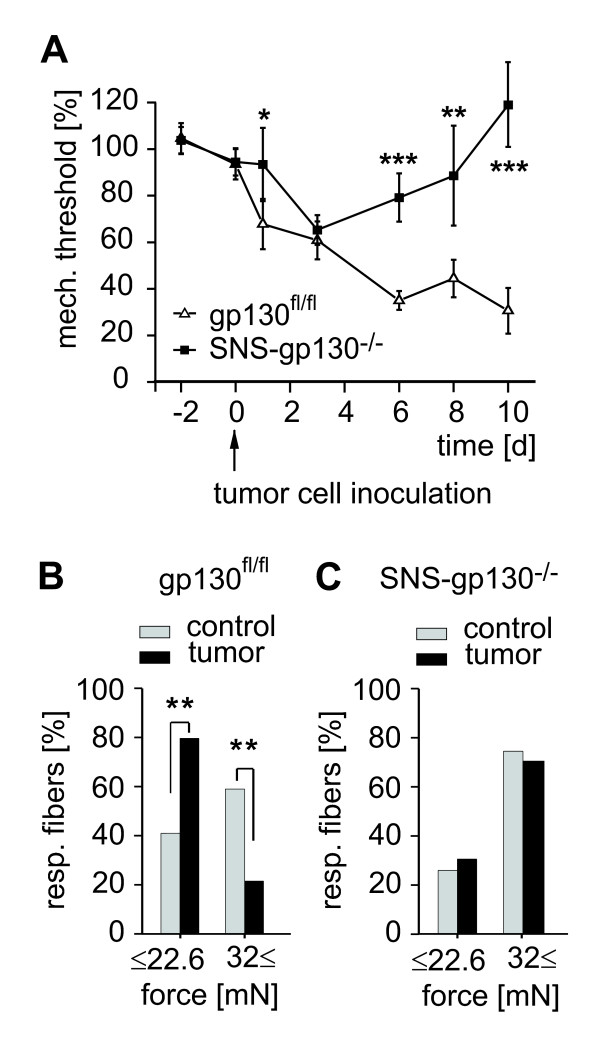
Neuronal signal transducer gp130 plays a role in tumor-induced mechanical hyperalgesia. (A) Mechanical threshold after tumor induction in the hind-paw of gp130fl/fl (open triangle n = 17) and SNS-gp130-/- (black square, n = 11) mice. After inoculation with tumor cells mechanical thresholds dropped by 30% in both mouse strains, but in SNS-gp130-/- mice the degree of hypersensitivity was significantly reduced in comparison to gp130fl/fl mice at day 1, 6, 8, and 10 (* p < 0.05, ** p < 0.01, *** p < 0.001; ANOVA). (B, C) Mechanical von Frey thresholds of fibers recorded in in vitro skin-nerve preparation from gp130fl/fl and SNS-gp130-/- mice at 7 to 10 days post inoculation. Nociceptors from gp130fl/fl mice projecting into tumor area showed lower thresholds (≤ 22.6 mN, n = 28) than fibers innervating healthy skin (n = 66, ** p < 0.01; χ2-test), whereas no difference was found between healthy and tumor skin in SNS-gp130-/- animals.